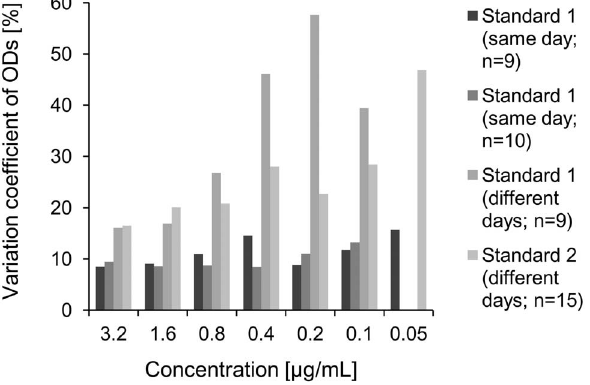
Figure 3. Inter-assay variability of optical densities (ODs) of a -Syn-nAbs standards measured on plates coated with a -Syn on the same day (assays # 1, # 2) and coated on different days (assays # 3, #